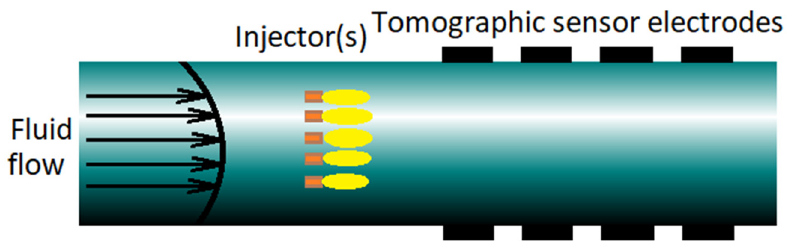
Figure 3. Schematic sketch of the concentration distribution control Figure 3 . Schematic sketch of the concentration distribution control process.